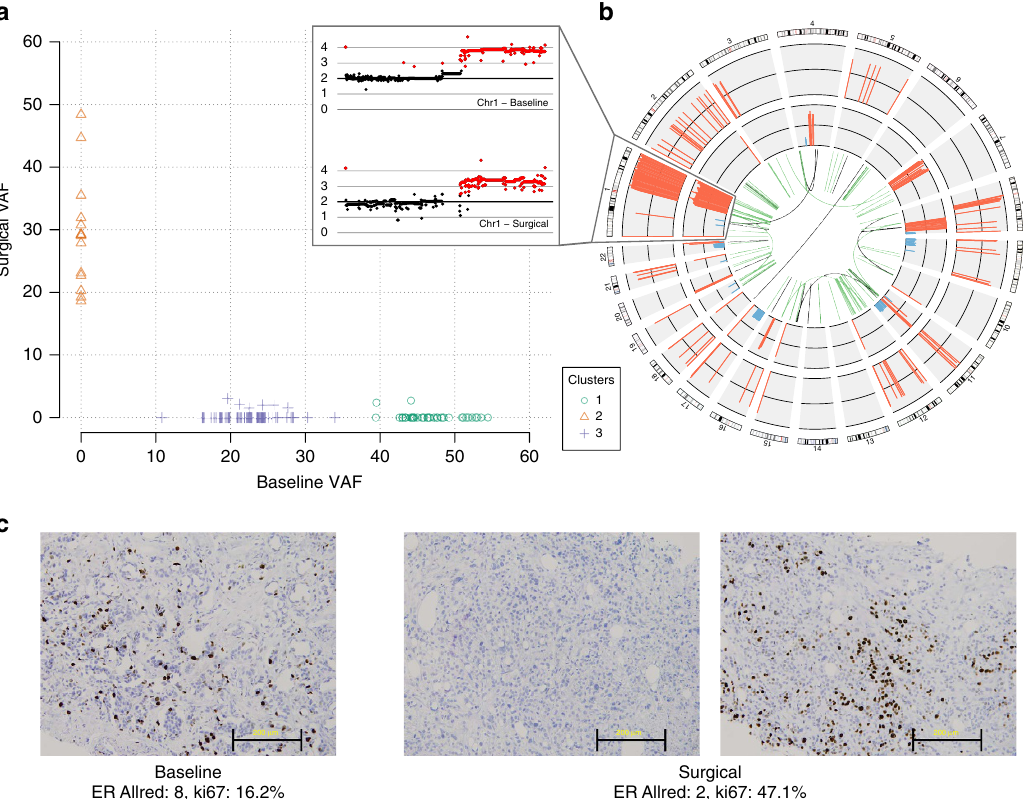
Baseline Surgical ER Allred: 8, ki67: 16.2% ER Allred: 2, ki67: 47.1% Figure 1 | Collision tumours of independent origin and ER status in BRC38. ( a ) Clonality plot comparing the VAFs of SNVs in the baseline and surgical samples. ( b ) Gene fusions and copy number alterations. Outer ring: CN alterations in the baseline sample (amplifications in red, deletions in blue). Inner ring: CN alterations in the surgical sample. Centre: gene fusion events that were specific to the baseline (green) or surgical sample (brown). Expansion: CN alterations on chromosome 1. ( c ) Immunohistochemistry results indicate the ER status of one baseline (left) and two surgical samples (middle, right). Scale bars, 200 m m. NATURE COMMUNICATIONS|7:12498|DOI: